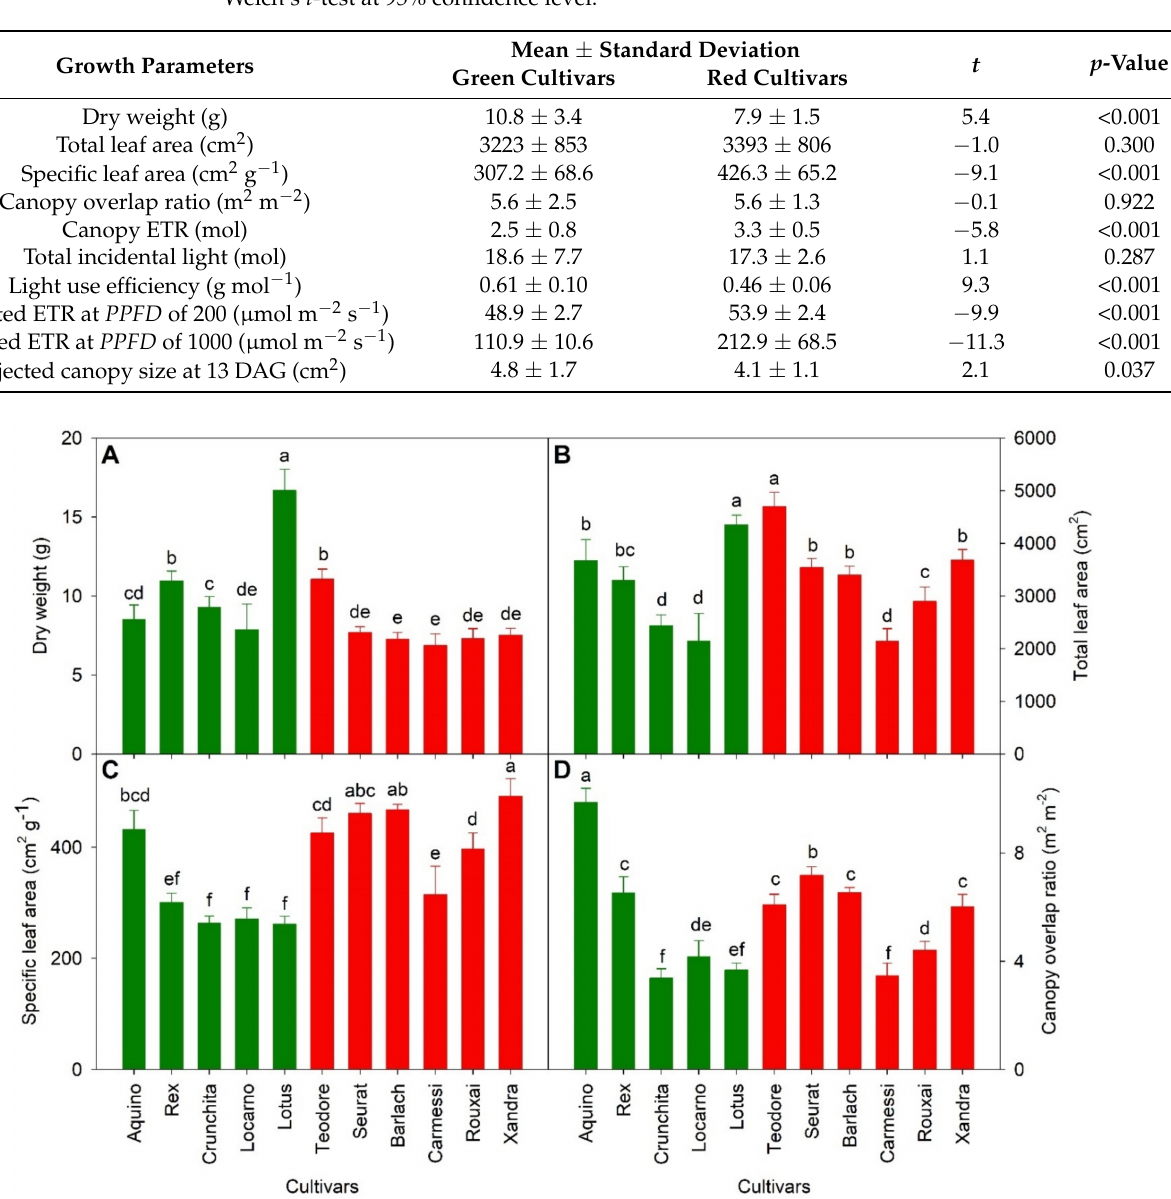
Table 1. Comparison of growth parameters between green (n = 48) and red (n = 60) leaf lettuces using Welch’s t -test at 95% confidence level.